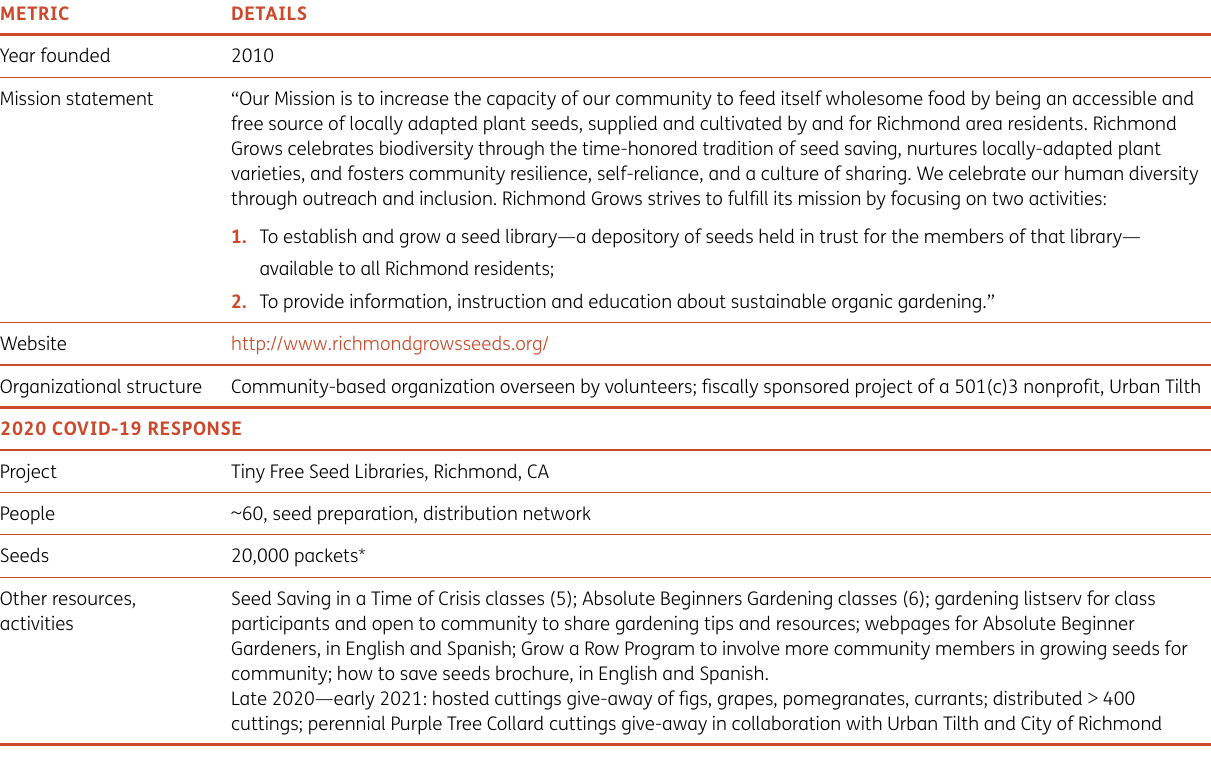
Table 2 Richmond Grows Seed Lending